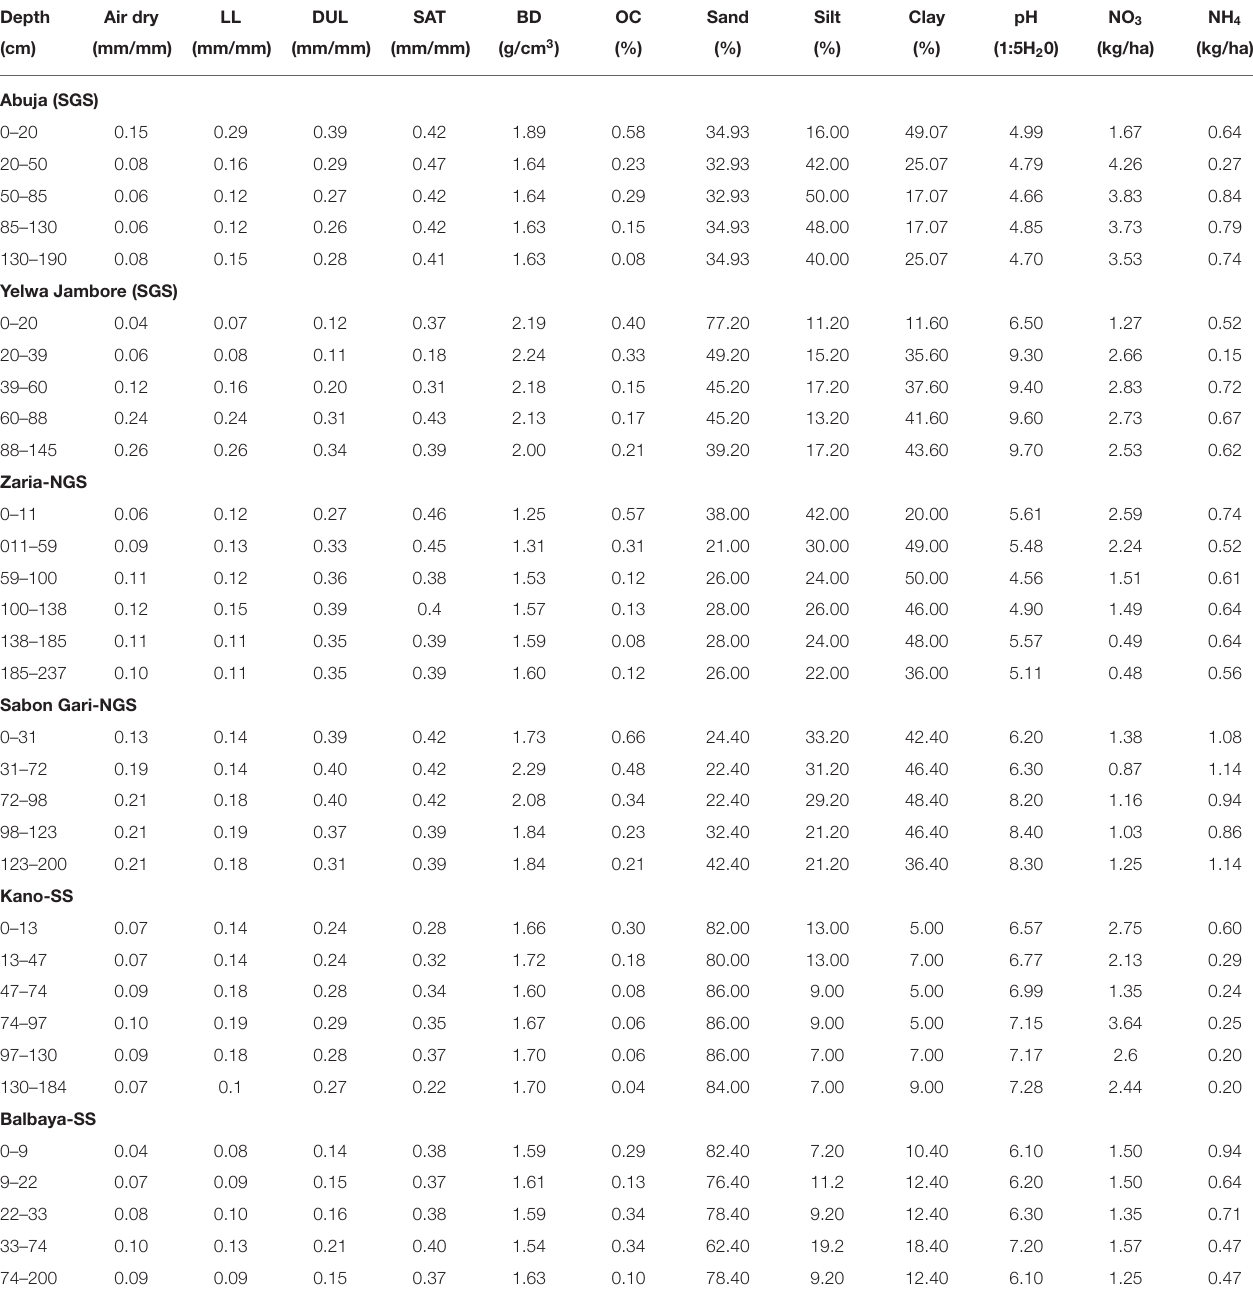
TABLE 1 | Soil physical and chemical properties used for APSIM soil parameterization, evaluation and model application of the study sites.